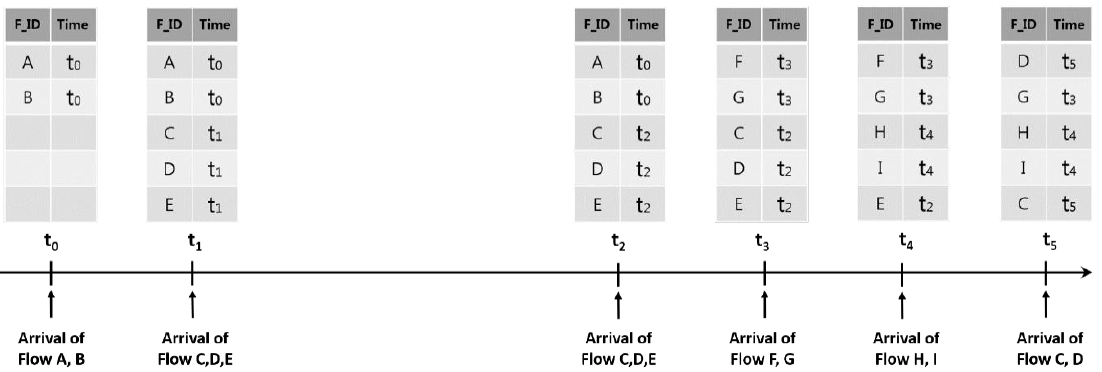
Figure 3. An example of inefficient flow entry replacements.